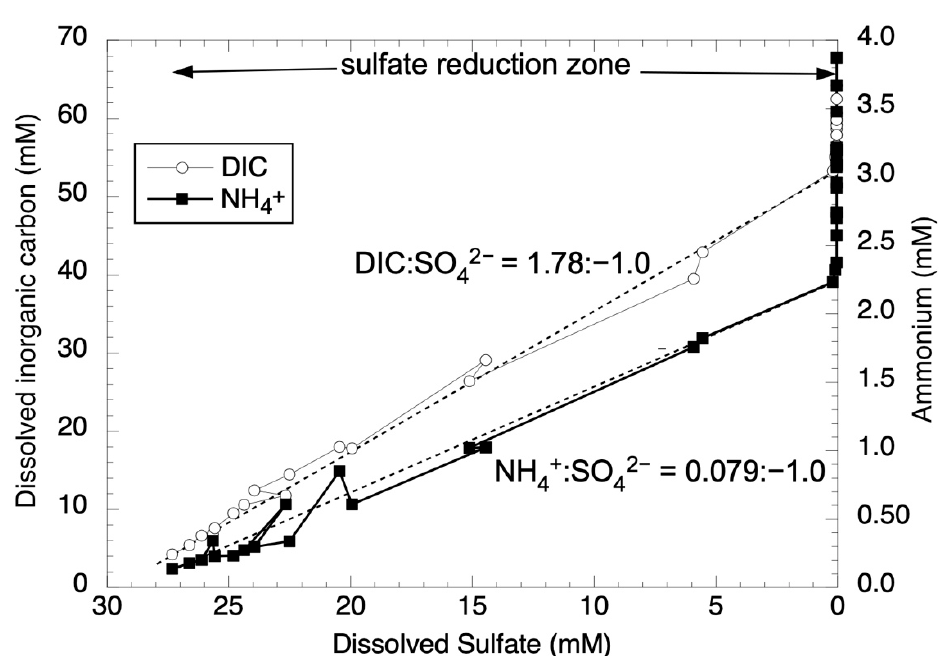
Figure 3. Linear stoichiometric relationship between dissolved inorganic carbon (DIC) and ammo- nium with dissolved sulfate in core ANT 1138-2. The DIC and ammonium continue to increase below the SRZ, as shown.